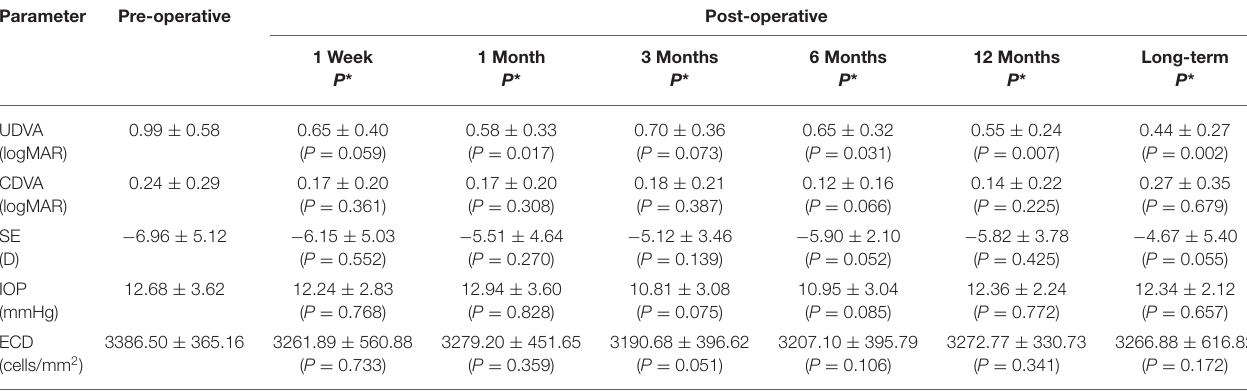
TABLE 3 | Functional analysis, pre-operative and 1 day, 1 week, 1, 3, 6, 12 months, and long-term post-operatively. Parameter